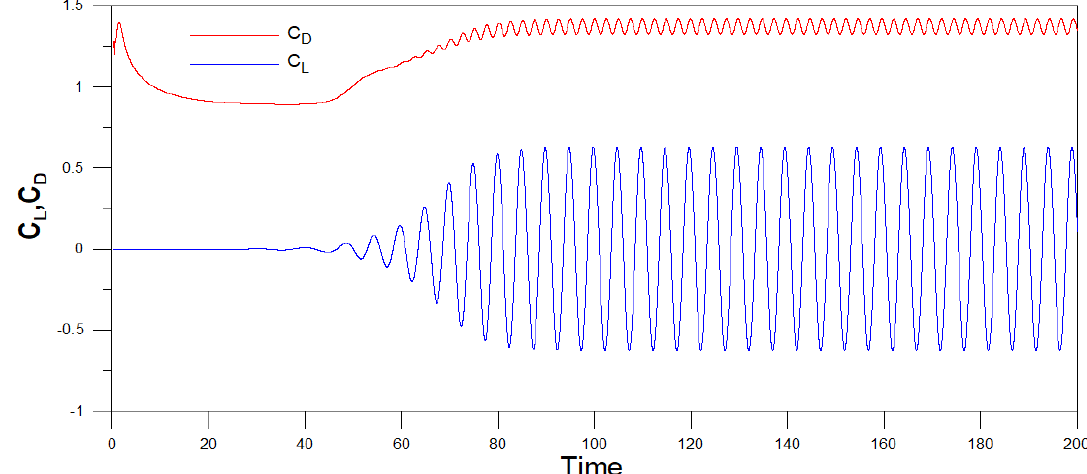
Figure 3. Drag and lift coefficients at Re = 200. Table 1. Drag coefficient and reattachment length for flow past a stationary cylinder at Re = 20 and Re = 40.